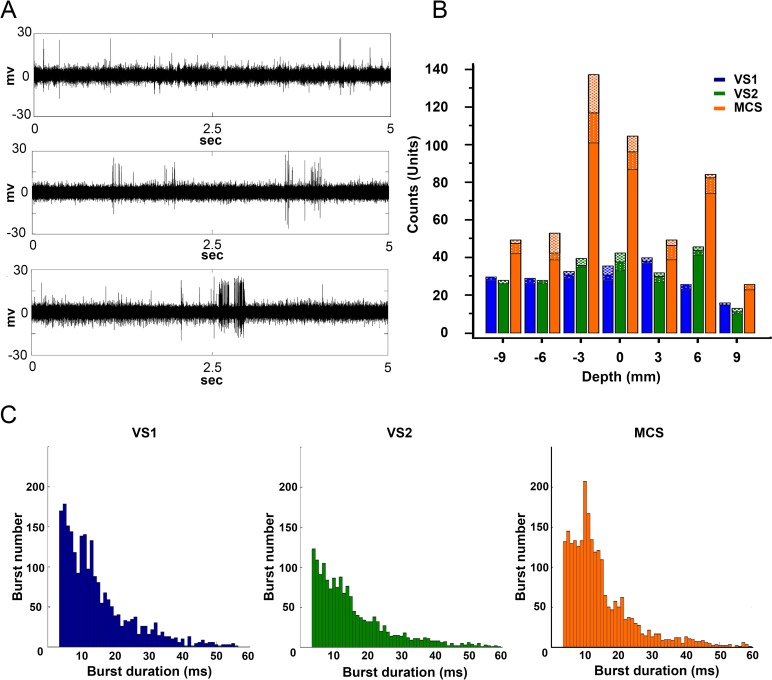
Characterization of the single unit activities recorded in the thalami.(a) Examples of activities recorded in the thalamus of the patients affected by DOC before sorting. The duration of all traces is 5 sec. The upper trace from VS1, shows mainly SN discharging randomly. The middle trace from VS2, shows randomly BN, with burst duration less than 15 ms. The lower trace from MCS, shows randomly BN, with two bursts lasting longer than 150 ms (MCS). (b) Histograms showing the distribution of burst durations in each patient. Two-way anova test showed that bursts durations were different at each depth (F = 2.85, P = 0.0165). Burst durations were significantly different when we compared MCS and VS1 (Wilcoxon ranksum test with Bonferroni correction: ranksum = 68; P = 0.0018) and MCS and VS2 (Wilcoxon ranksum test with Bonferroni correction: ranksum = 85, P< 0.0001), this was true independently from the depth of the recording. (c) Histogram showing the distribution of the single units recorded at different depths in the thalami of the 3 patients VS1 (blue), VS2 (green) and MCS (red). The distribution of the recorded units was significantly different in MCS, VS1 and VS2 (χ2 = 38.148; DF:12; P < 0.001). Units were classified according to their prevalent activity into SN and BN, and BN units were further subdivided into units with burst lasting for <14 ms (squared texture) or >13 ms (stippled texture). Differences in the distribution of the 3 class of units according to the level explored was significant only in MCS (χ2 = 25.395; DF:12; P < 0.013) while in VS1 and VS2 units were uniformly distributed at all levels.